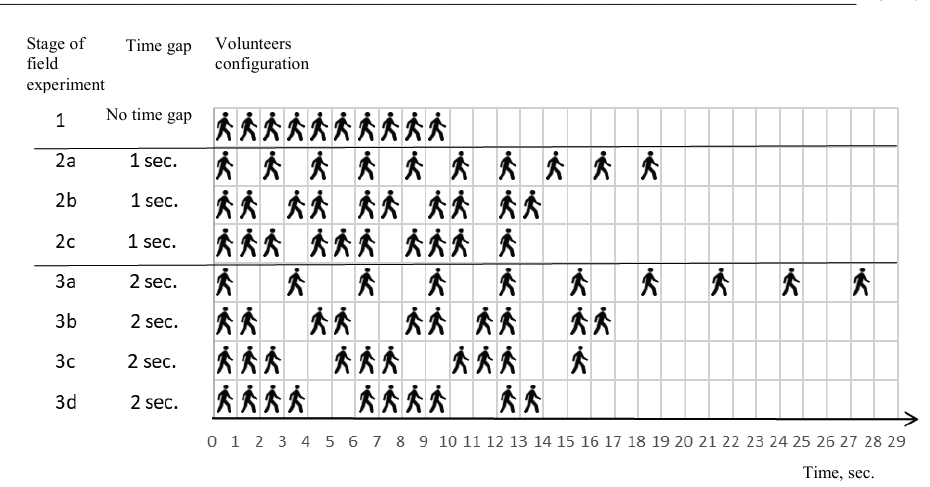
Fig. 1 . Stages of field experiment wit h configuration of